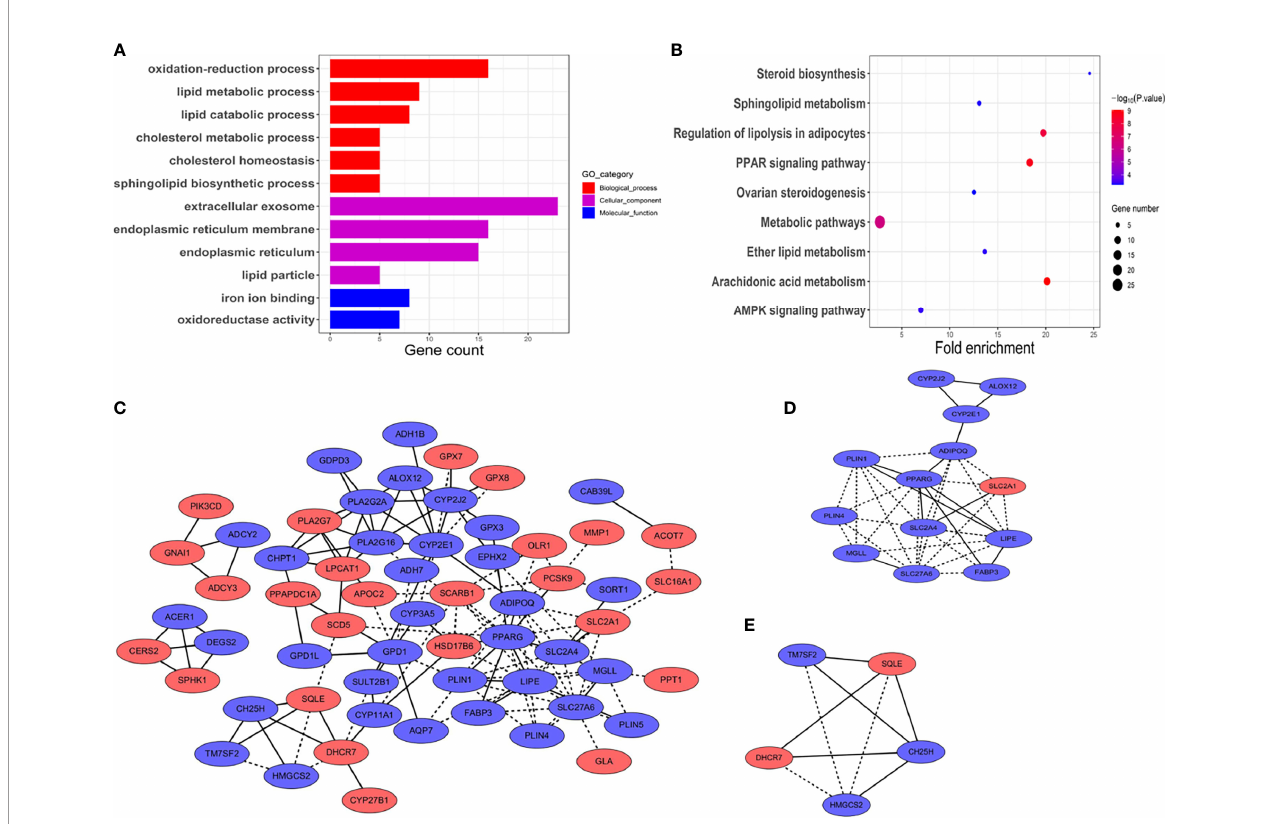
FIGURE 2 | Functional vanalyses and PPT network of the DEGs. (A) GO analysis including biological processes, cellular components, and molecular functions. The x -axis shows gene counts enriched in these processes. ( p < 0.01, FDR < 0.05). (B) Pathway analysis of the DEGs showed the common pathways in the KEGG database. The size of the points represented the numbers of the enriched genes; the bigger the size, the more genes enriched. Blue to red points represented statistical signi fi cance from low signi fi cance to high signi fi cance ( p < 0.01, FDR < 0.05). (C) PPI network of the DEGs. Blue represents down-expressed genes, and red denotes up-expressed genes. Solid lines represent known interactions from curated databases or experimentally determined. Dotted lines represent predicted interactions. (D, E) Key module genes, namely, module 1 and module 2, with scores of 6.17 and 4.5,